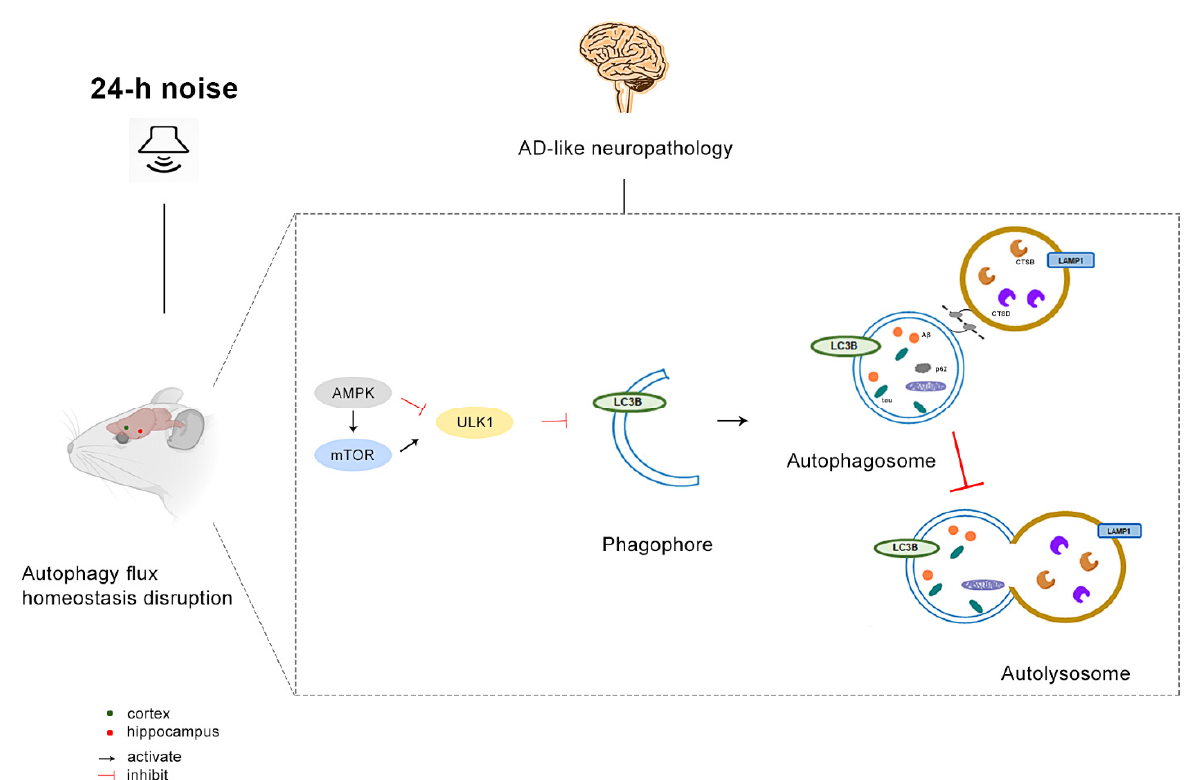
Figure 6. Around-the-clock noise (24 h/day) exposure disrupts autophagy flux, inducing AD- like neuropathology. Schematic representation of the findings of this study. Around-the-clock noise (24 h/day) exposure leads to AMPK inhibition, which then activates mTOR signaling to inhibit autophagy. Autophagy is impaired in the stages of autophagosome–lysosome fusion and degradation in rats exposed to around-the-clock noise. Inhibition of autophagy associated with around-the-clock noise exposure may aggravate the burden of APs and foster the development of AD-like